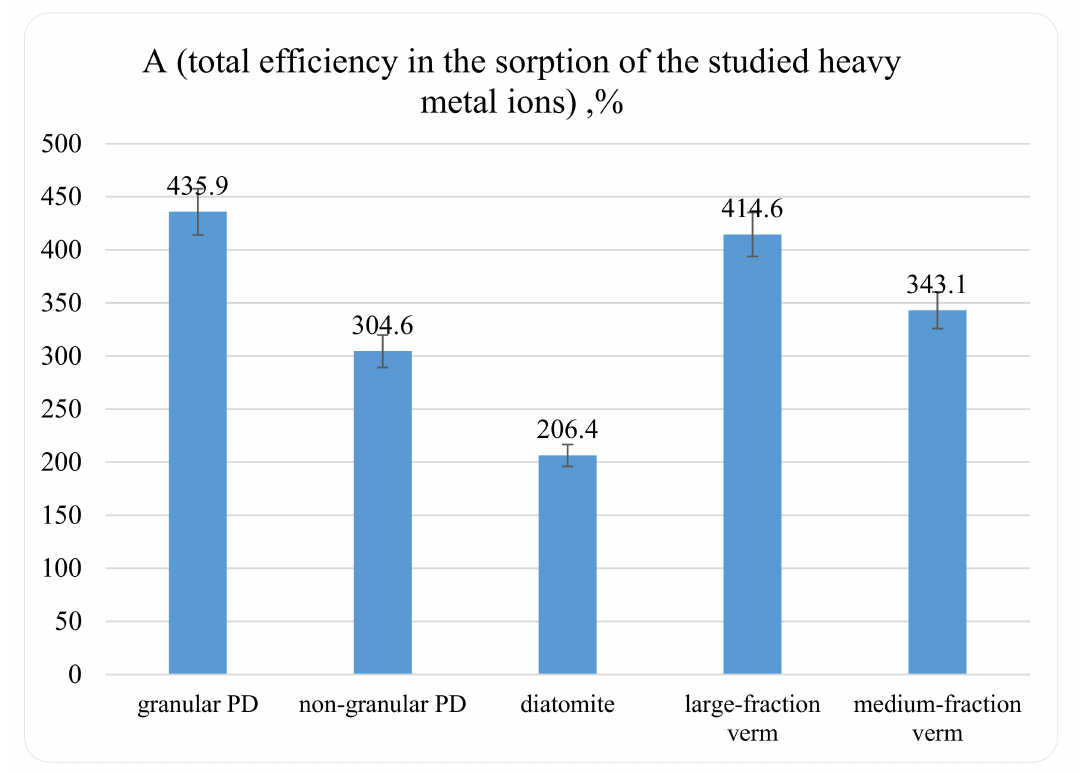
Figure 2. The total value of the degree of extraction of heavy metal ions (A) by various sorbents.